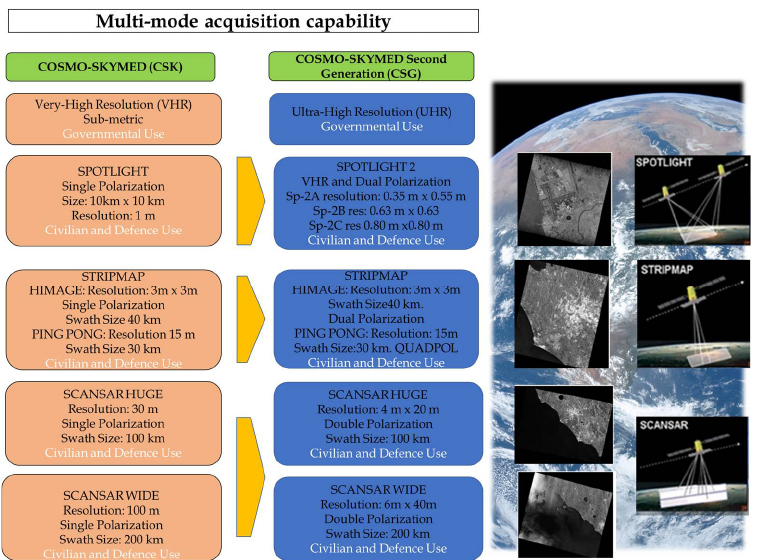
Figure 11. Comparison of SAR imaging types supported by CSK (orange)/CSG (blue), ©ASI: Italian Space Agency.